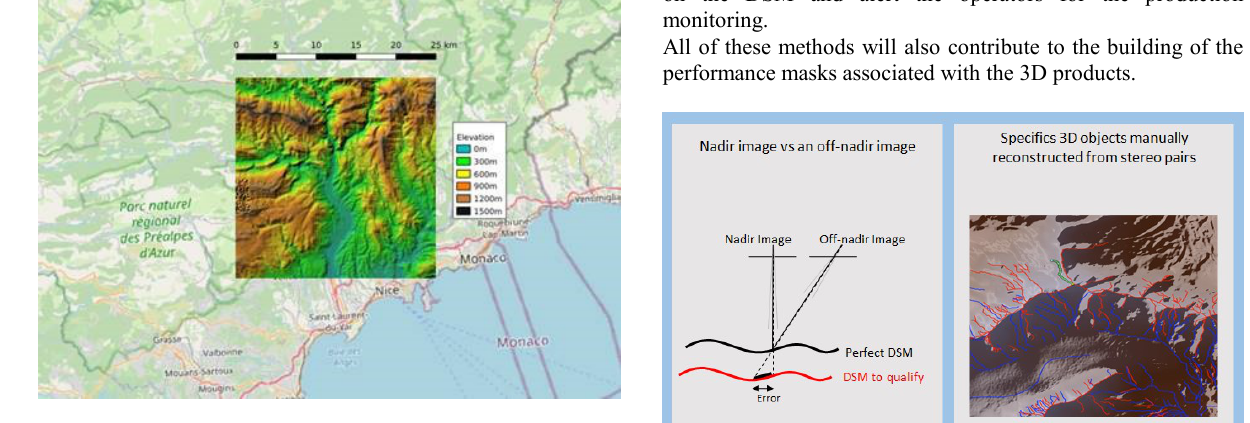
Figure 13. Example of one GLOBAL-DEM tile